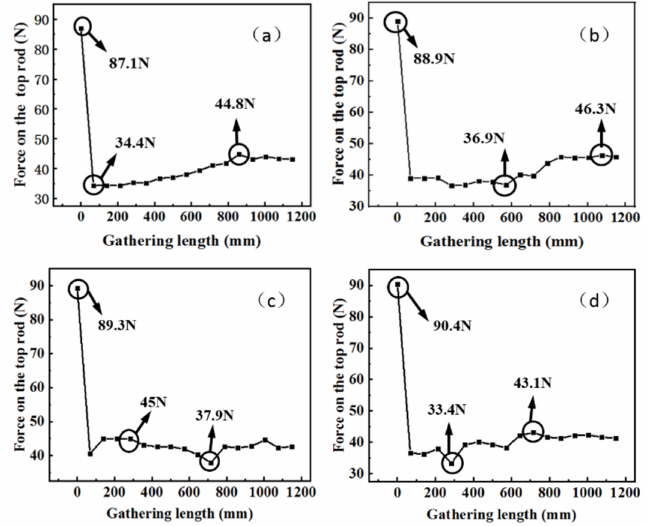
Figure 15. The force diagram of the top rod during the gathering process of the ( a ) first test; ( b ) second test; ( c ) third test; and ( d ) forth